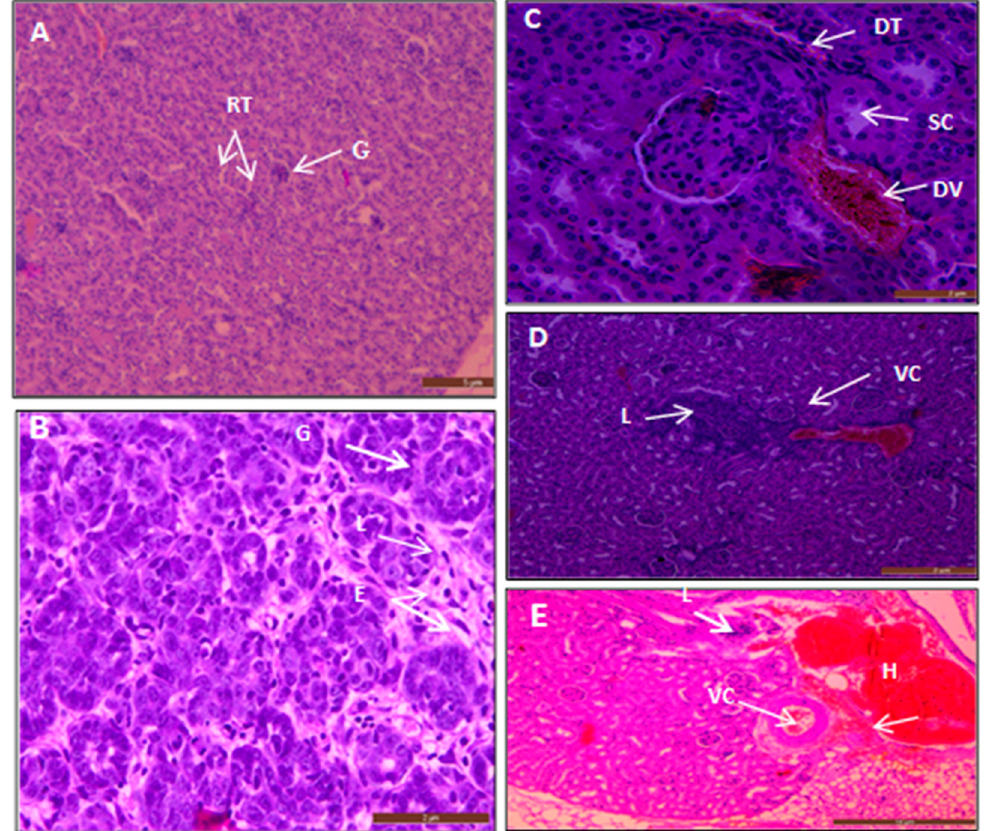
Figure 12. Sections of kidney mice. ( A ) Kidney of control mouse reveals normal glomeruli (G) and normal renal tubules (RT). ( B ) Kidney of mouse administered with an oral dose of 300 mg/kg AgNPs reveals mild chronic inflammation with lymphocytes (L) surrounded by edema (E) (white in color). ( C ) Section from mice treated with 300 mg/kg represents a prominent dilated blood vessel (DV) filled with RBCs. It shows dilated tubules (DT) with swelling of cells (SC) as reversible injury and hydropic changes occurred. ( D ) Kidney of mice treated with 200 mg/kg shows vascular congestion (VC), dilated blood vessels filled with RBCs and lymphocytes (L) (chronic inflammatory cells infiltration). Moreover, lymphocytes with vascular congestion are seen in ( E ) as it shows kidney of mice treated with 300 mg/kg; it also demonstrated a hemorrhage (bleeding) (H). Stained with hematoxylin and eosin. Scale bar= 5 μ m for ( A ), 2 μ m for ( B – D ), and 10 μ m for ( E ).